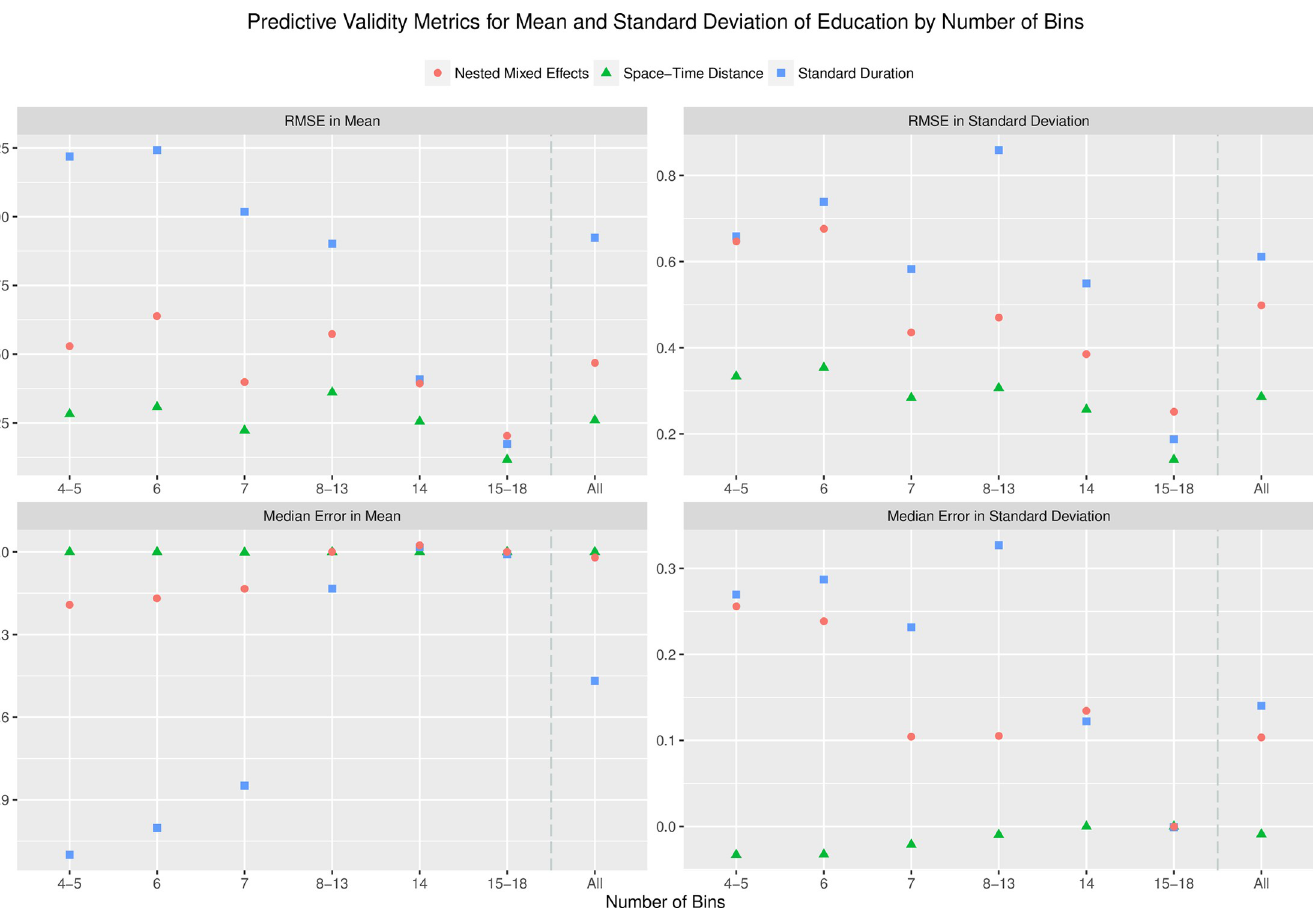
Fig 1. Predictive validity by number of bins. Predictive validity metrics for the mean and standard deviation of attainment are shown by number of bins present in the binning schema used. Space-time distance model results shown using hyper-parameter set with optimal RMSE in mean attainment. Overall the space-time distance model has the lowest error and bias, the nested mixed effects model performs intermediately, and the standard duration method has the poorest performance. All metrics of performance tend to improve as bin number increases, and the predictive task becomes easier.